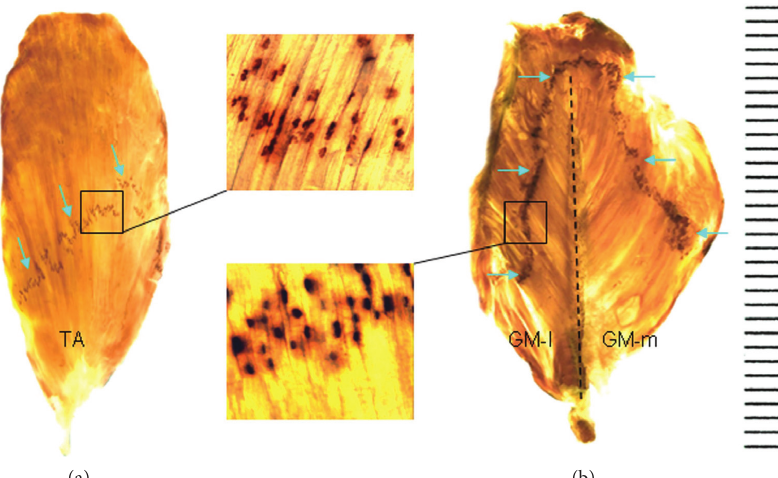
Figure 3: Locations of the MEP bands within the TA and GM as demonstrated by whole-mount AChE staining. (a) The MEP band (arrows) with numerous neuromuscular junctions (black dots) within the TA is located obliquely in the middle of the muscle. (b) Each of the GM-l and GM-m compartments in the GM has its own MEP band (arrows). The vertical dished line in the GM indicates midline.